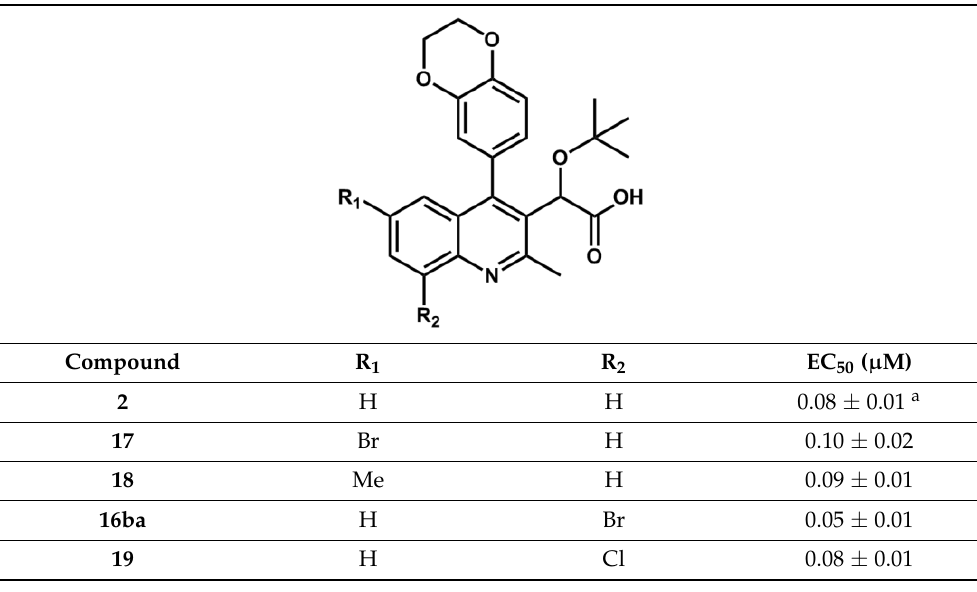
Table 4. In vitro IN multimerization EC50 activities of 8-substituted-4-(1,2-benzendioxanyl) quino- lines. a Data from Jentsch N. et al. (2018).